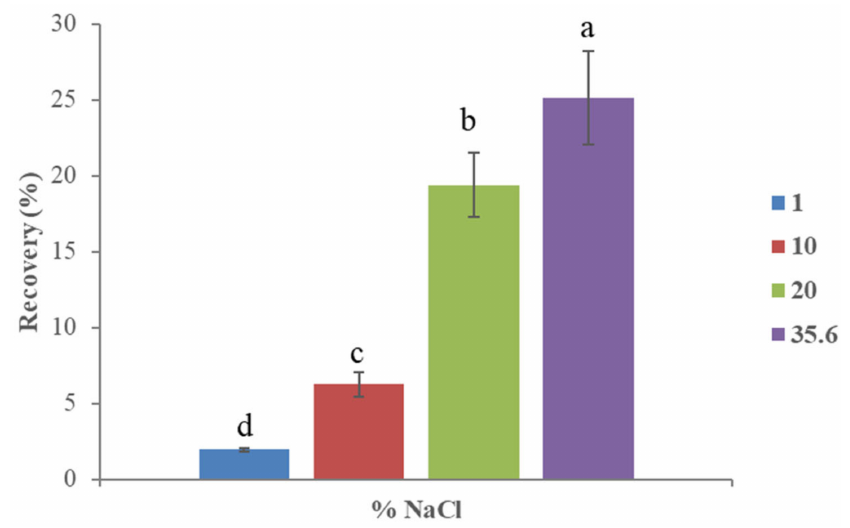
Figure 1. Effect of NaCl addition at various concentrations on the extraction recovery of carotenoids from LTW; standard deviation of three replicate analyses is presented with error bars; different letters (i.e., a–d) denote samples that differ significantly (statistical difference for p < 0.05).